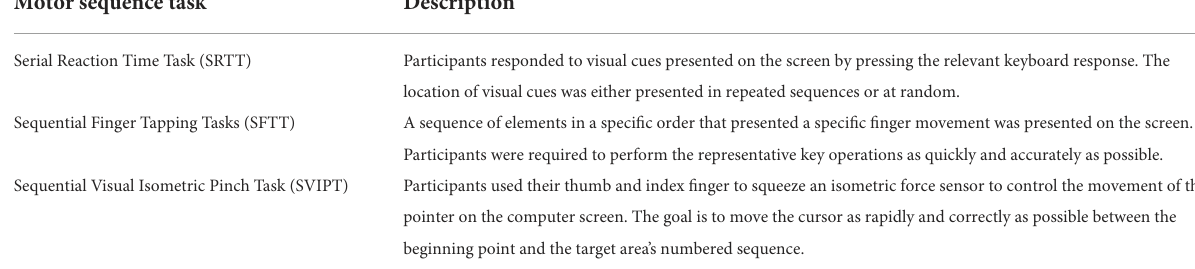
TABLE 2 Characterization of the main motor paradigms described in this Systematic